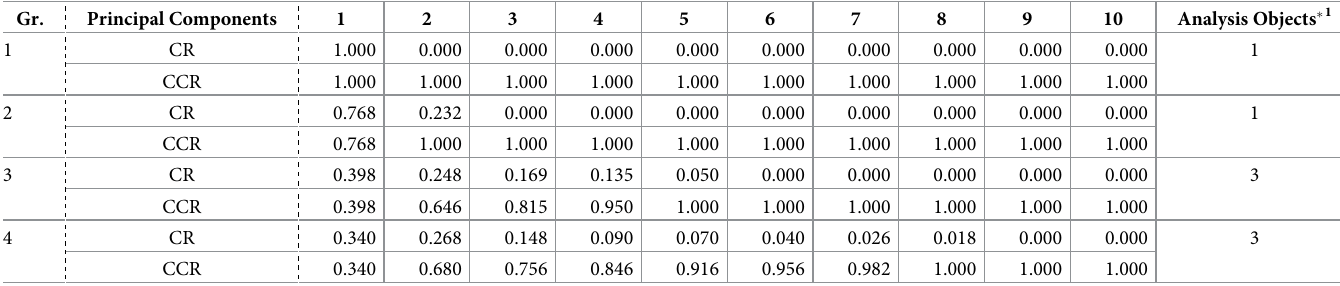
Table 3. Contribution of the connections between artificial intelligence fields in the principal component analysis (2018).